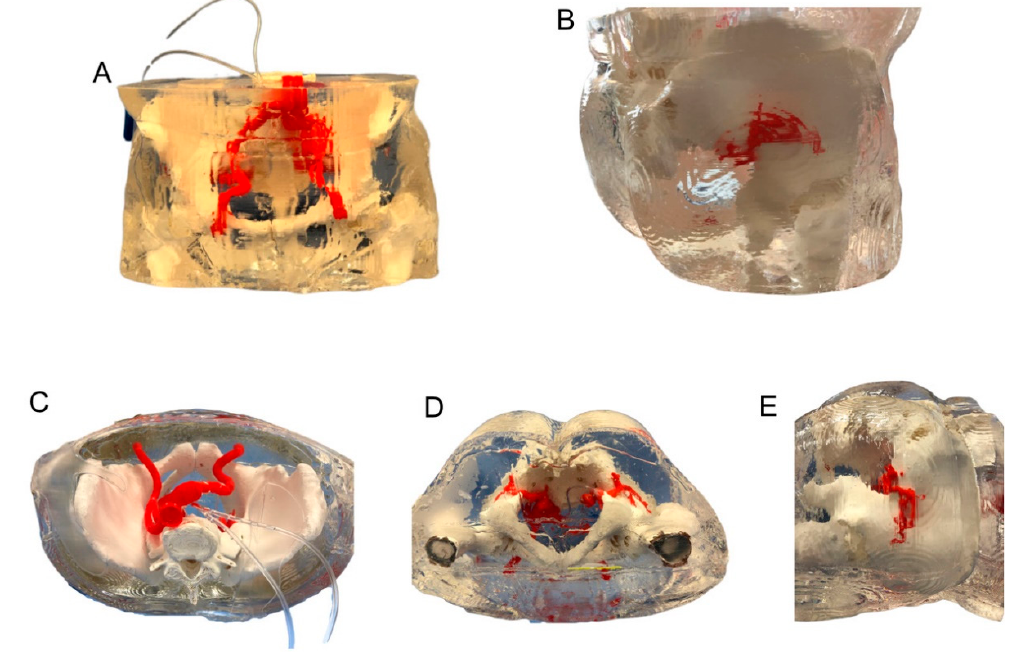
Figure 4. Silicone model. ( A ) Front view ( B) Lateral rear view ( C ) Top view ( D ) Bottom view ( E ) Side view.